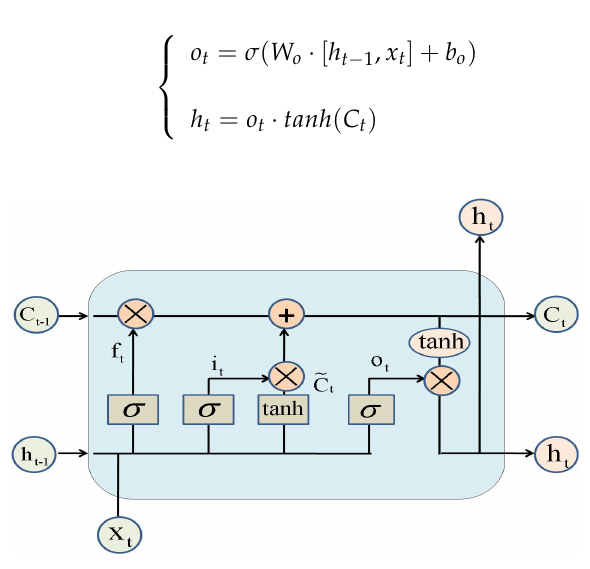
Figure 2. Structure diagram of LSTM